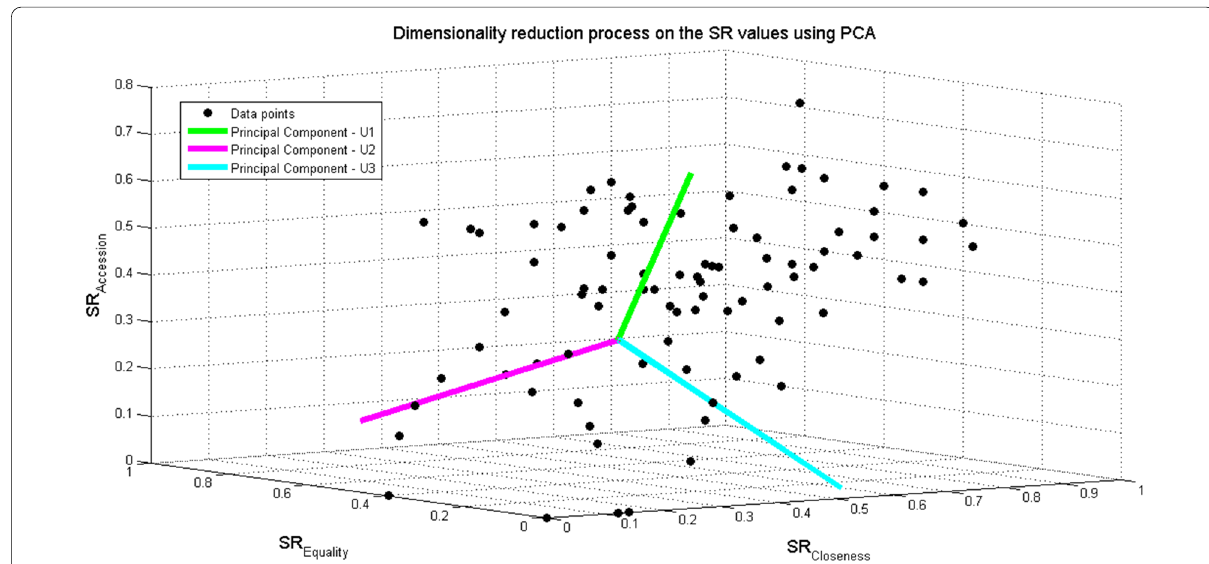
Fig. 4 Applying dimensionality reduction to the SR values by PCA. All three SR points of each player (closeness, equality, and accession) are displayed within a 3D plane, together with the principal components obtained following dimension reduction